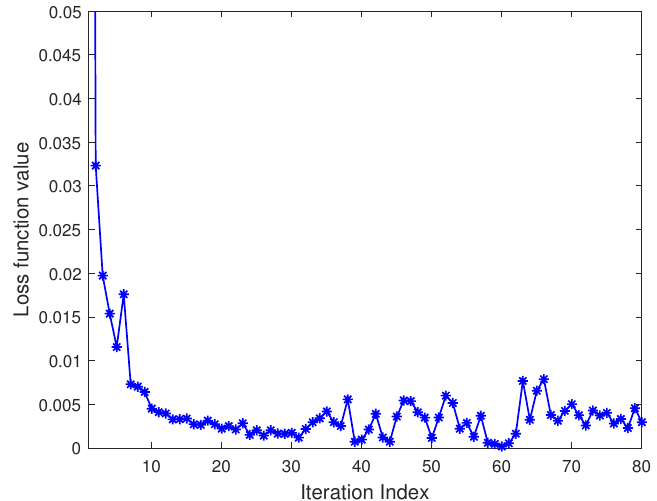
Figure 9. Convergence performance of the Convolutional-LSTM network.